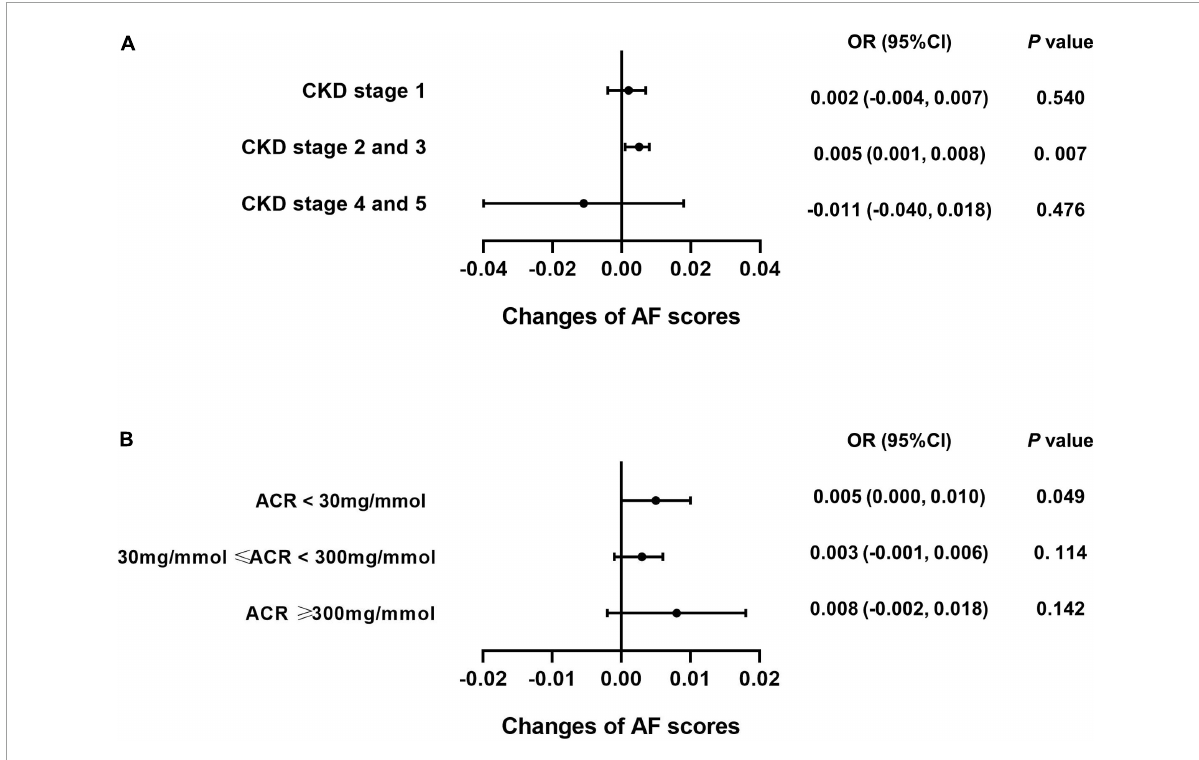
FIGURE5 Caffeine benefits the performance on the Animal Fluency Test (AF) in CKD stage 2 and 3 patients. We performed logistic regression analysis of caffeine intake and AF scores in each CKD stage subgroup (CKD stage 1 = 59 subjects, CKD stage 2 and 3 = 362 subjects, CKD stage 4 and 5 = 21 subjects) and urinary albumin creatinine ratio (ACR) subgroup (ACR < 30 mg/mmol = 196 subjects, 30 mg/mmol ≤ ACR < 300 mg/mmol = 210 subjects, ACR ≥ 300 mg/mmol = 36 subjects). Forest plots show the odds ratios of all subgroups. For CKD stage 2 and 3 patients, caffeine intake significantly improved the AF scores (OR = 0.005, 95% CI: 0.001–0.008, P = 0.007, A ). For CKD stage 1, 4 and 5 patients, caffeine did not improve the AF scores (A) . Among the ACR groups, only patients with an ACR less than 30 mg/mmol benefited from caffeine intake (OR = 0.005, 95% CI: 0.000–0.010, P = 0.049, B